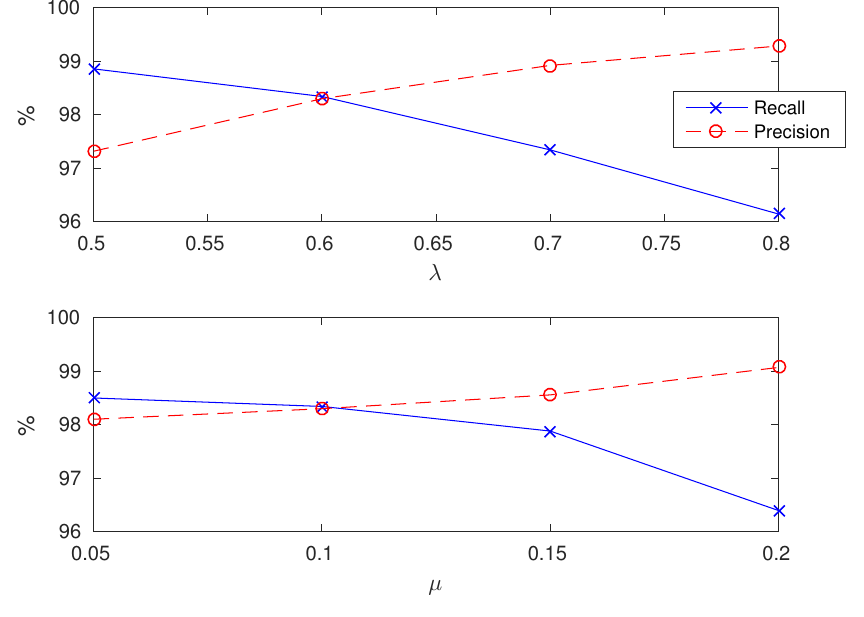
Figure 6. Influence of λ ( top figure ) and µ ( bottom figure ) on the precision and recall of the method. In the top figure, µ is set to its default value µ = 0.1. In the bottom figure, λ is set to its default values λ =